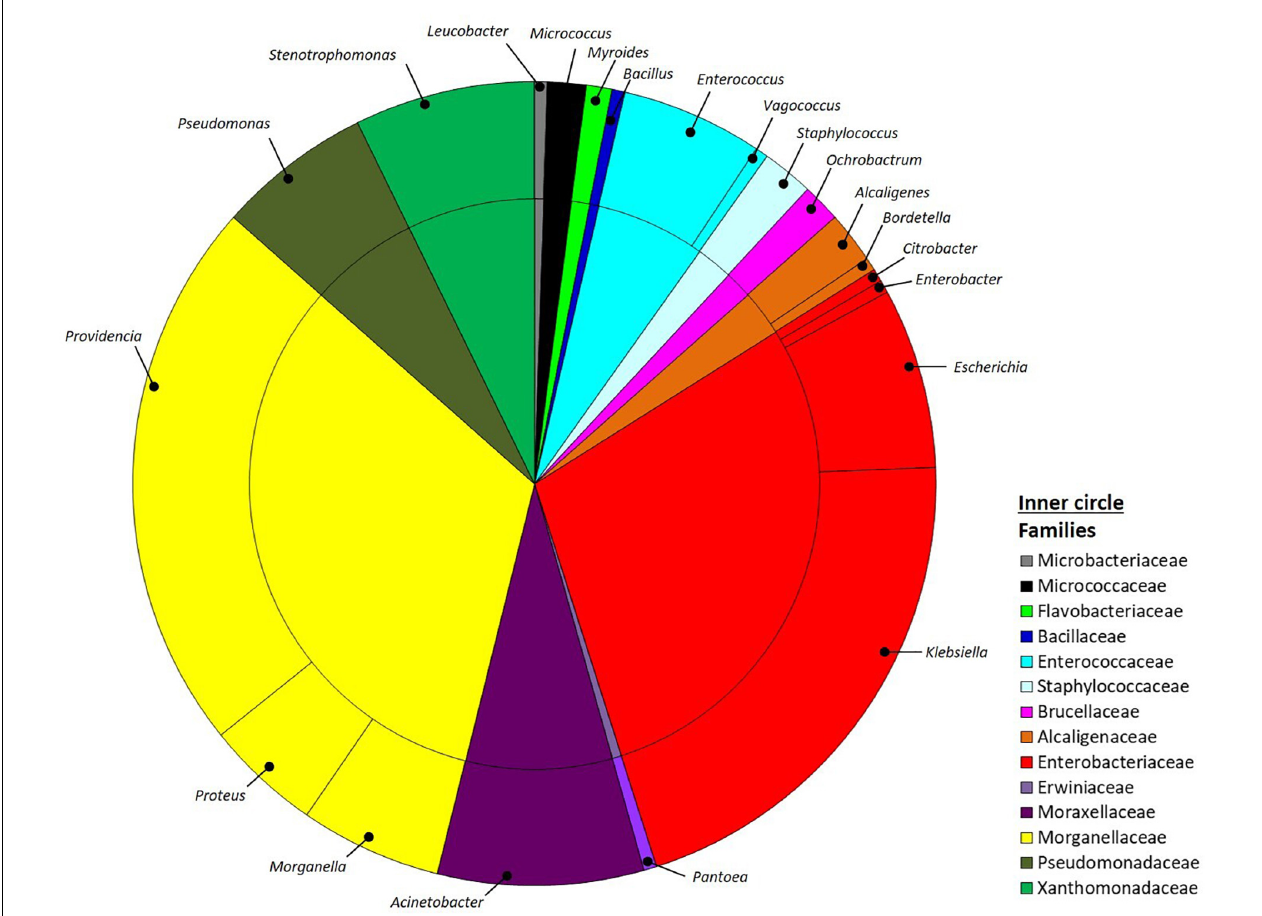
FIGURE 1 | Pie-charts representing the relative culturable bacterial diversity associated to H. illucens larvae. Bacterial diversity is expressed at the genus (outer circle) and family (inner circle)